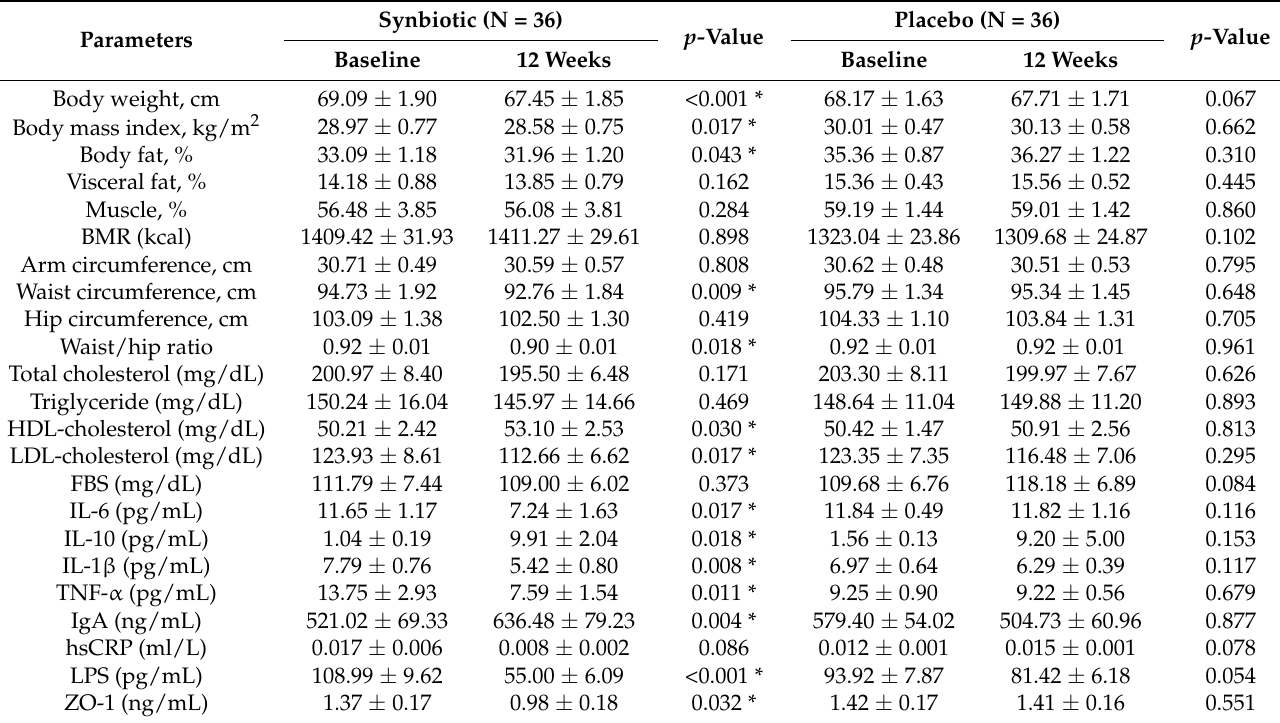
Table 2. Changes in the studied parameters within groups at different times, expressed as mean ± SE.